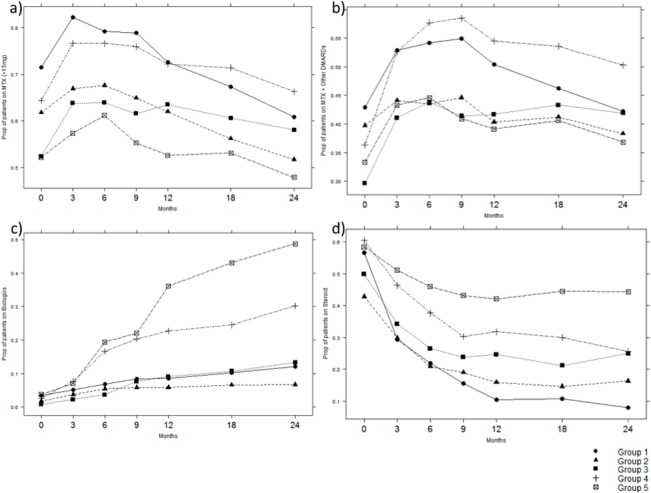
Treatment by Trajectory Group.(A) Group Proportion on Methotrexate (≥15 mg), by Visit Month. (B) Group Proportion on Combination Methotrexate and DMARD Therapy, by Visit Month. (C) Group Proportion on Biologics, by Visit Month. (D) Group Proportion on Corticosteroids, by Visit Month.